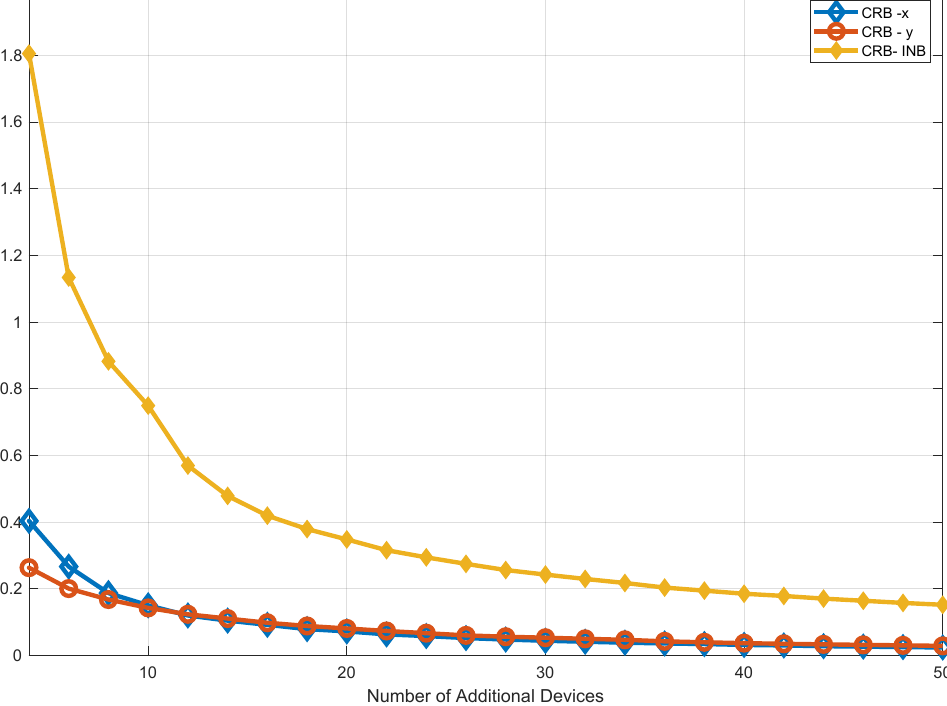
Figure 7. CRB as a function of the number of additional receivers for the three unknowns: the two coordinates x , y (blue and red, respectively) and the INB